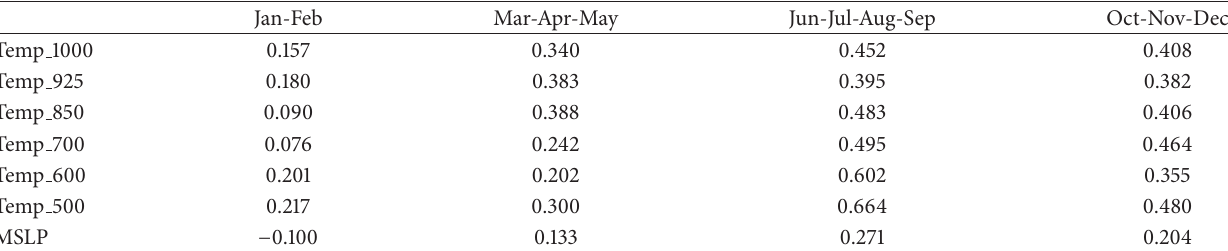
Table 9: Correlation of GPCP with temperature and MSLP, by Monte Carlo